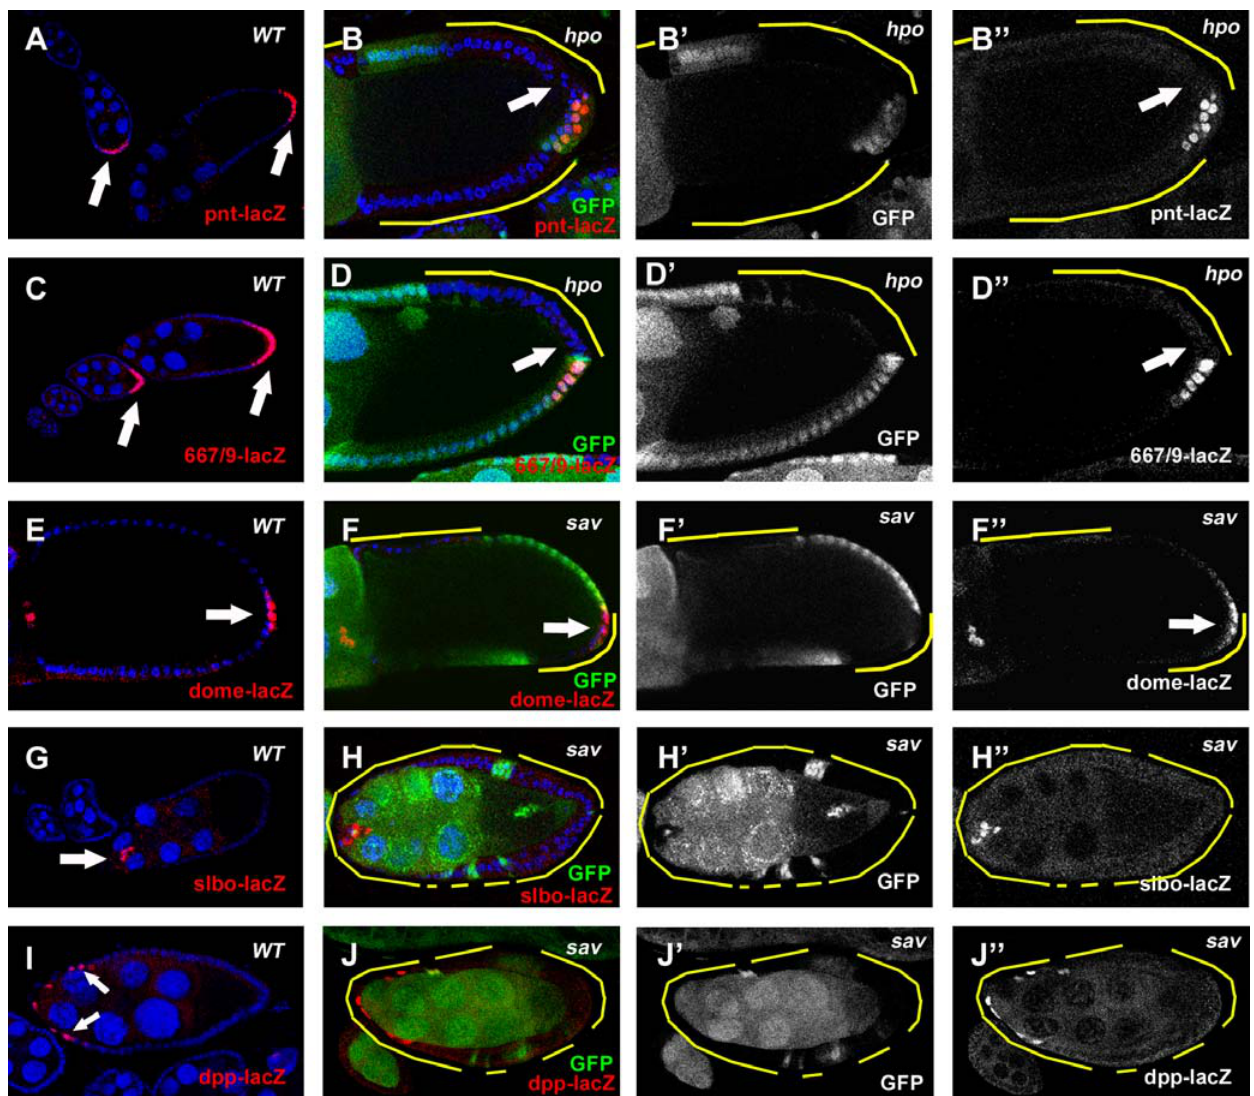
Figure 2. Mutants of the Hpo pathway disrupt PFC differentiation. The PFC markers pnt-lacZ (A) and 667/9-lacZ (C) are specifically expressed in the PFC after stage 6 in wild-type egg chambers. (B and D) hpo PFC clones fail to express pnt-lacZ (B) or 667/9-lacZ (D), in a cell-autonomous manner (arrows). (E) Activation of JAK-STAT signaling in the PFC (arrow) can be marked by the expression of dome-lacZ . (F) In sav PFC clones, expression of dome-lacZ is not affected (arrow). The AFC markers slbo-lacZ (G) and dpp-lacZ (I) are expressed in the AFCs in stage-9 wild-type egg chambers. In sav mutant PFC, no misexpression of slbo-lacZ (H) or dpp-lacZ (J) was detected.